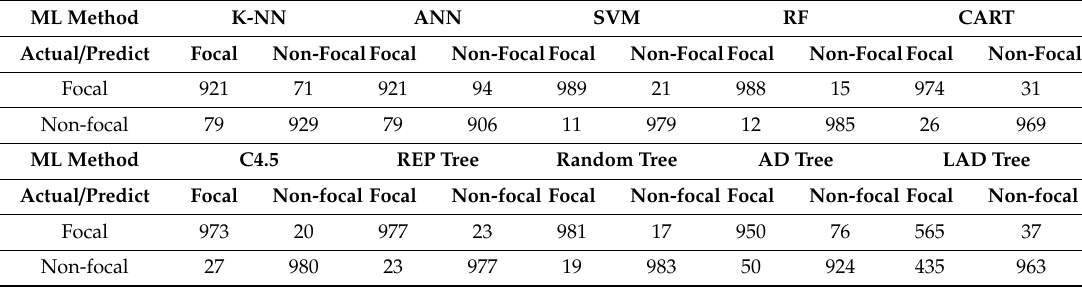
Table A2. Confusion matrix for